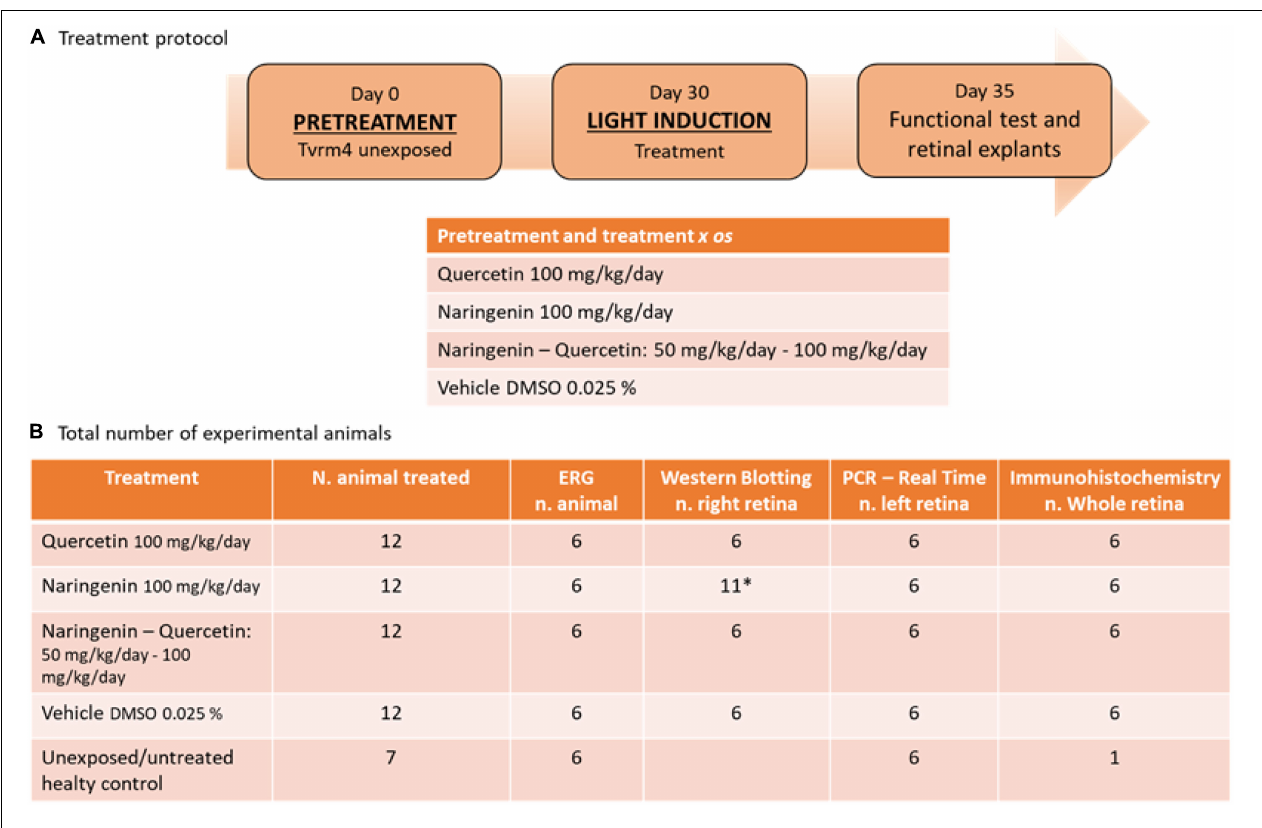
FIGURE 1 | Treatment protocol and the number of animals used for the experimental plane. (A) Summary outline of the treatment protocol and the relative doses used for treatment with single molecules and treatment with molecules in combination. (B) Descriptive table of the total number of animals used for this study, with a detailed breakdown of how biological samples were used. ∗ Due to the variability of the results of this treatment n = 5 contralateral retinas were taken from the animals designated for whole-mount retinal tissue preparation (right